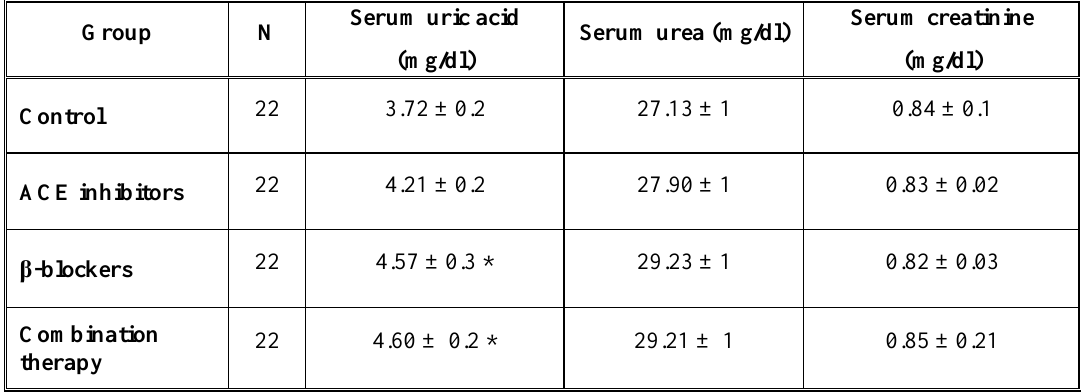
Table 7: Serum uric acid, serum urea and serum creatinine in control healthy individuals and retrospective hypertensive patients treated with different antihypertensive drug regimens. Each value represents mean± standard error of mean.